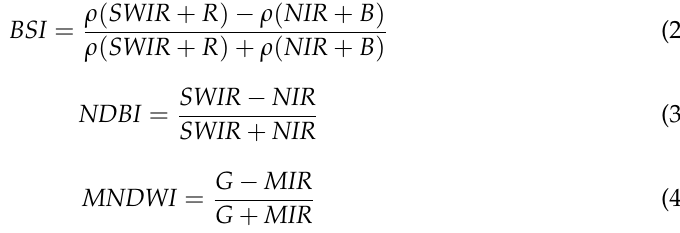
Figure 2. Effective number of Landsat images (cloud cover below 20%) of Mongolia from 1990 to 2021.